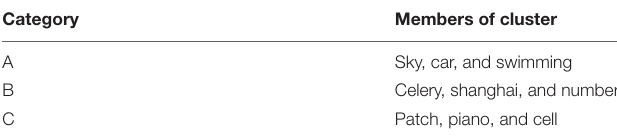
TABLE 3 | Words used in Experiment